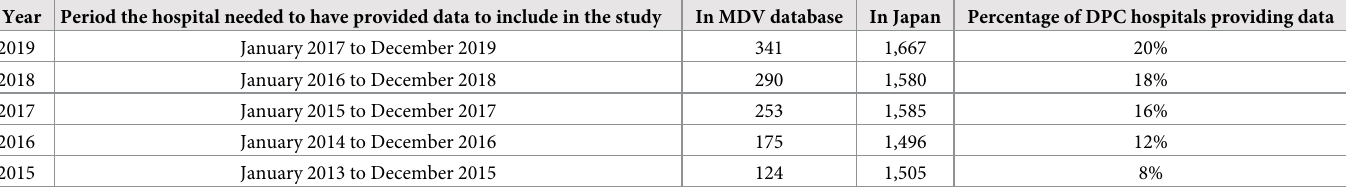
Table 2. Number of DPC hospitals in Japan and included in MDV database by year. Year Period the hospital needed to have provided data to include in the study In MDV database In